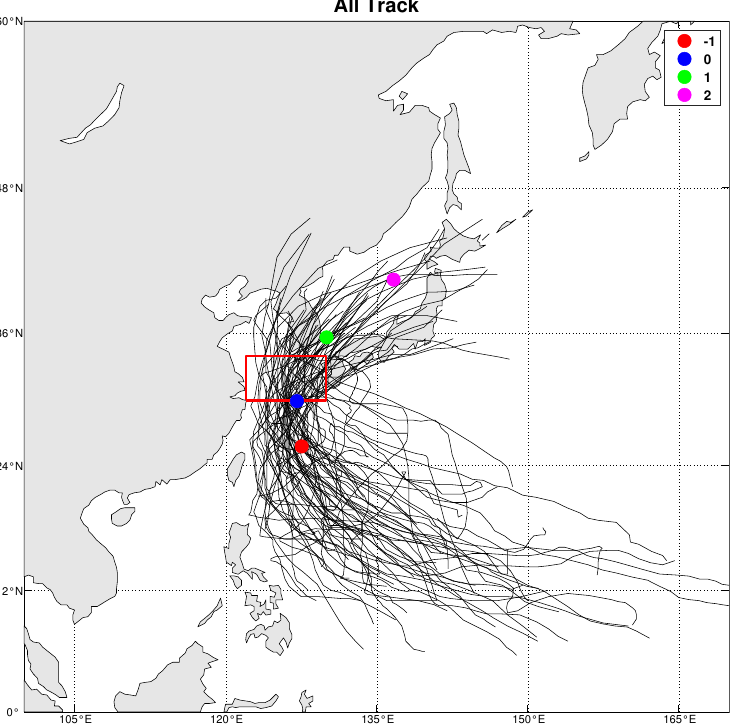
Figure 1. TC tracks analyzed in this study. The red box represents the region of 30–34° N and 122–129° E. The red, blue, green, and magenta dots indicate the average location of TCs at the − 1, 0, 1, and 2 days after the timing of passing through 30°